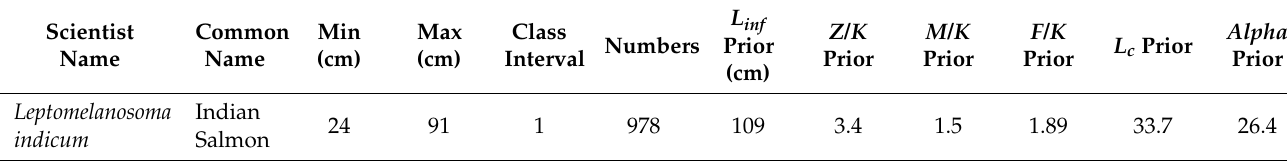
Table 1. Basic and prior information for LBB